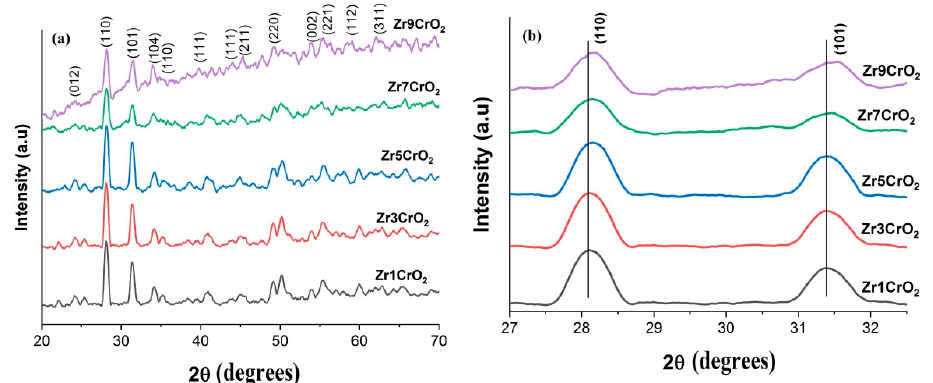
Figure 1. ( a ) Comparison of XRD spectra of Zr1CrO 2 , Zr3CrO 2 , Zr5CrO 2 , Zr7CrO 2 , and Zr9CrO 2 ; ( b ) XRD spectra demonstrating peak shifts of (110) and (101) diffraction planes.